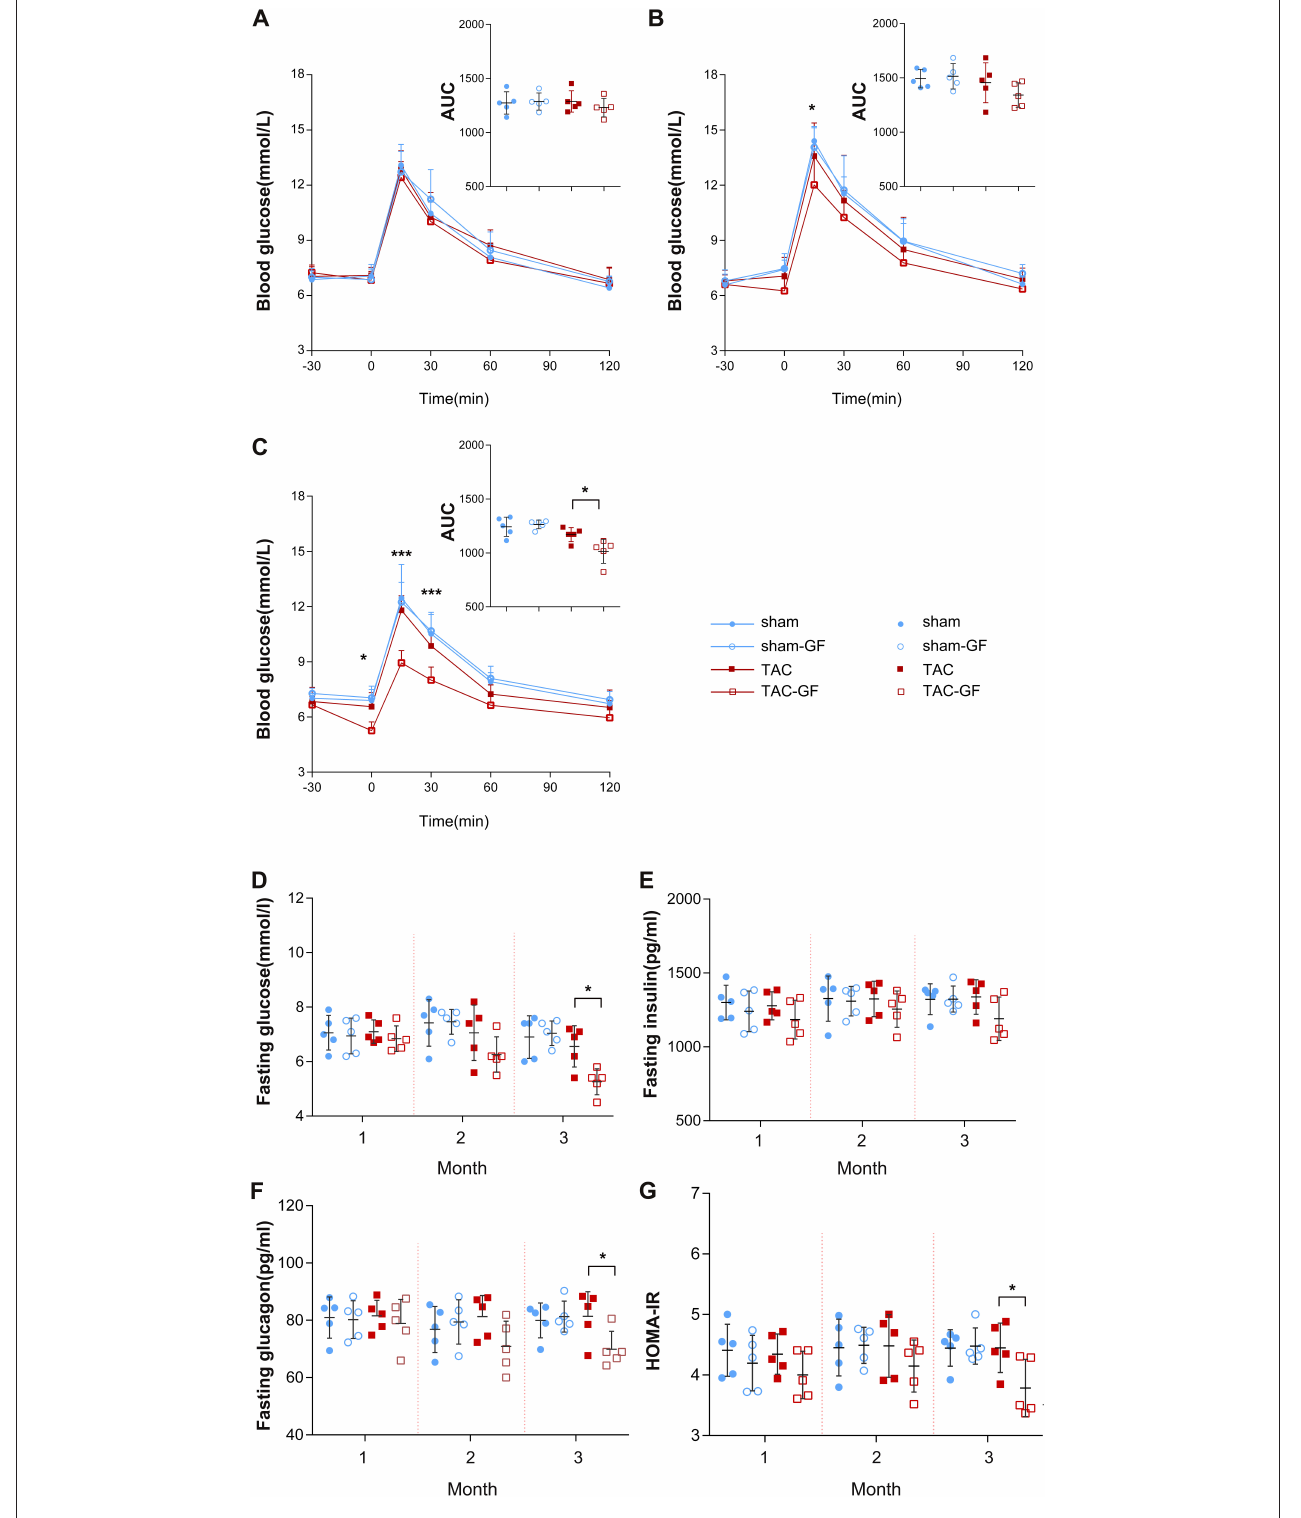
FIGURE 2 | The gut microbiota influence glucose tolerance after thoracic aortic constriction (TAC) surgery. (A–C) Intraperitoneal glucose tolerance test (IPGTT) performance in the TAC, TAC germ-free (TAC-GF), sham, and sham-GF groups each month after surgery. (D) Fasting glucose levels. (E) Fasting insulin levels. (F) Fasting glucagon levels. (G) Homeostasis model assessment for insulin resistance (HOMA-IR) value. n = 5. * p < 0.05.